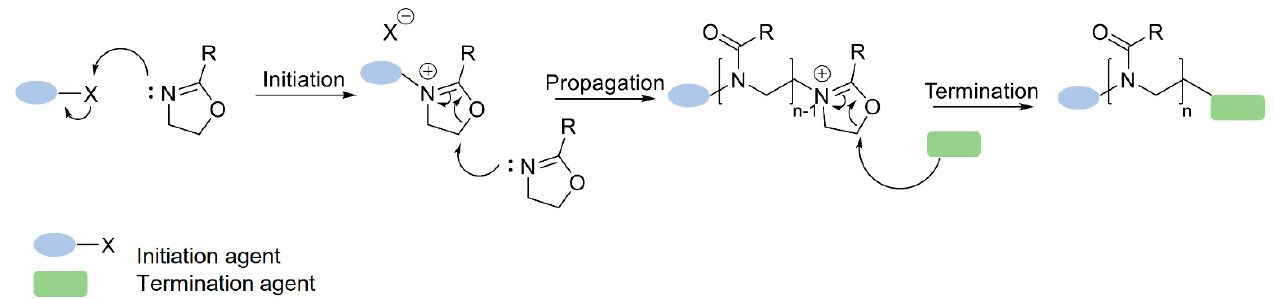
Figure 4. General mechanism of the living cationic ring-opening polymerization (CROP) of 2-oxazoline monomers. Adapted from [12].